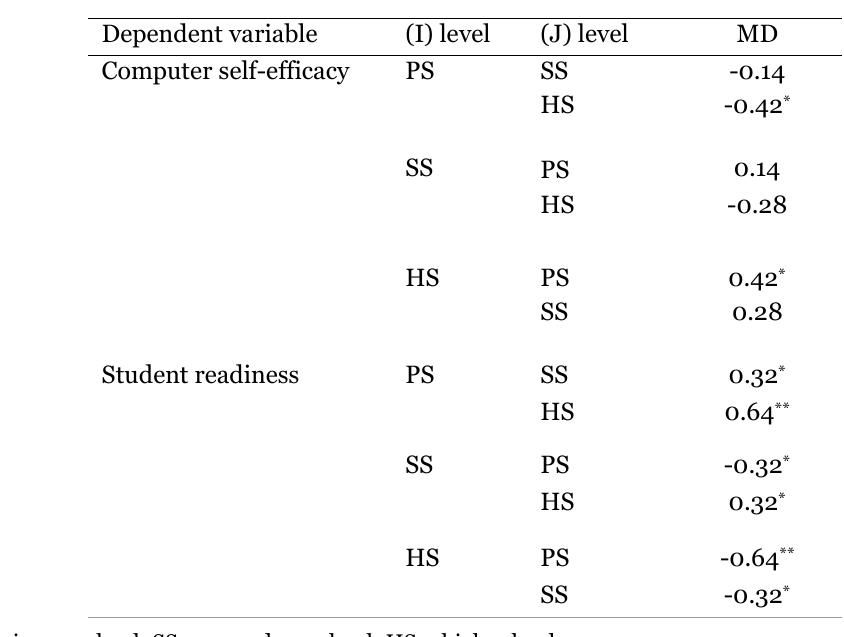
Post-Hoc (Bonferroni) Results